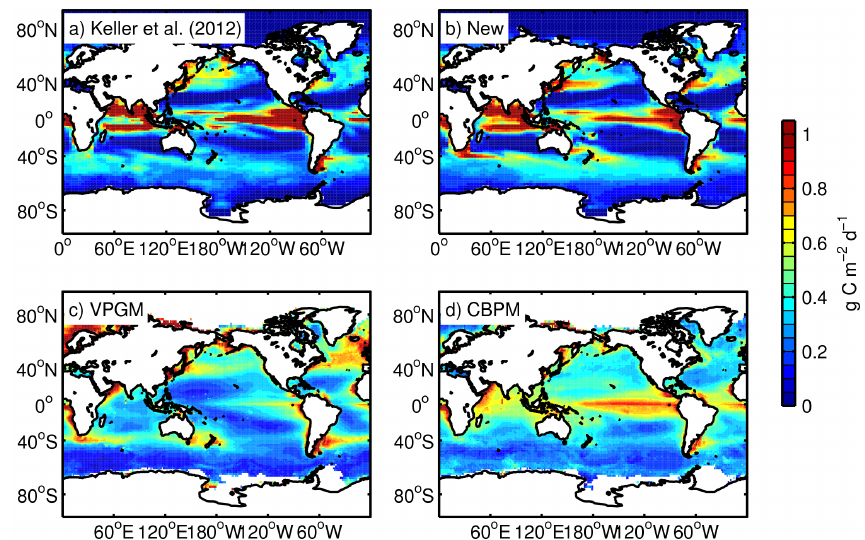
Figure 11. Marine vertically integrated annual mean net primary production for (a) the model by Keller et al. (2012), (b) the new model with the dynamic iron cycle, (c) the vertically generalized production model (VPGM) by Behrenfeld and Falkowski (1997), and (d) the carbon-based productivity model (CBPM) by Westberry et al. (2008).